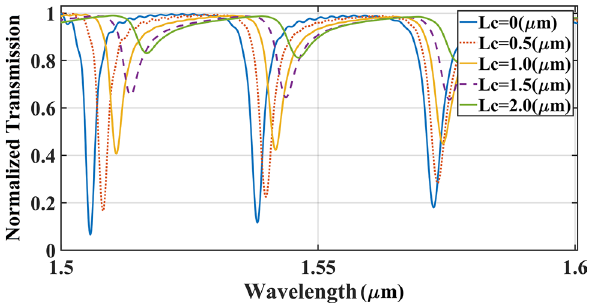
Figure 3. The transmission spectrum of ICCRR versus different 3 × 3 coupling length of Lc